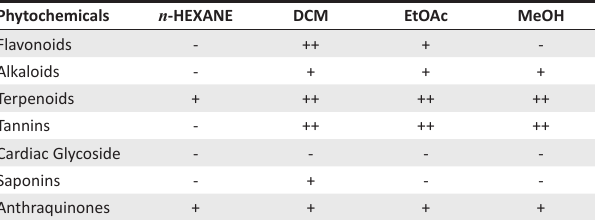
TABLE 1: Preliminary phytochemical screening of L . egregia stem bark extracts. Phytochemicals n